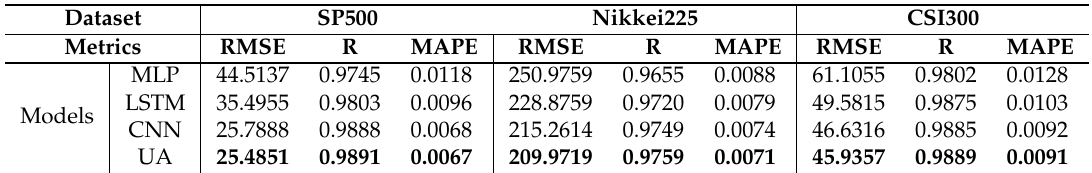
Table 3. Predicting results of all methods on the three market index price (best results displayed in boldface ).